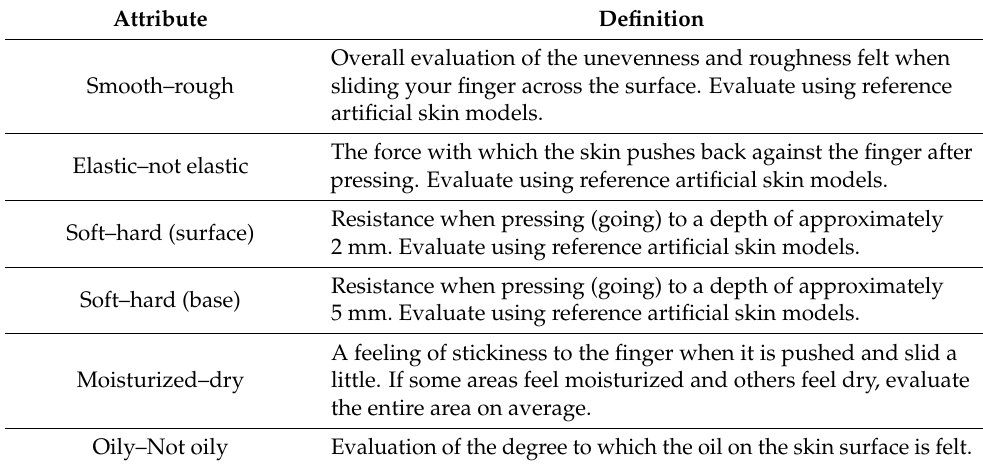
Table 1. Definitions of